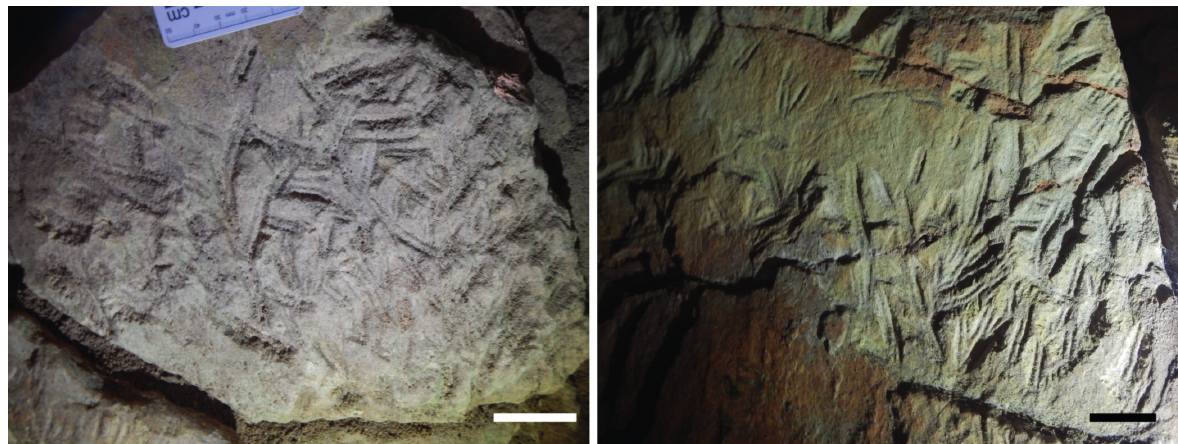
Figure 8 - Evidences of the overlapping of older traces by newer ones suggest that the grooves were produced during a long time span. Scale bar: 30